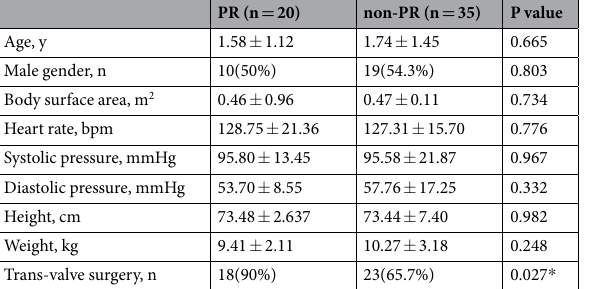
Table 1. Baseline characteristics of TOF patients. Note: Data given as the mean ± SD; TOF, tetralogy of Fallot; PR, pulmonary regurgitation. * P < 0.05.